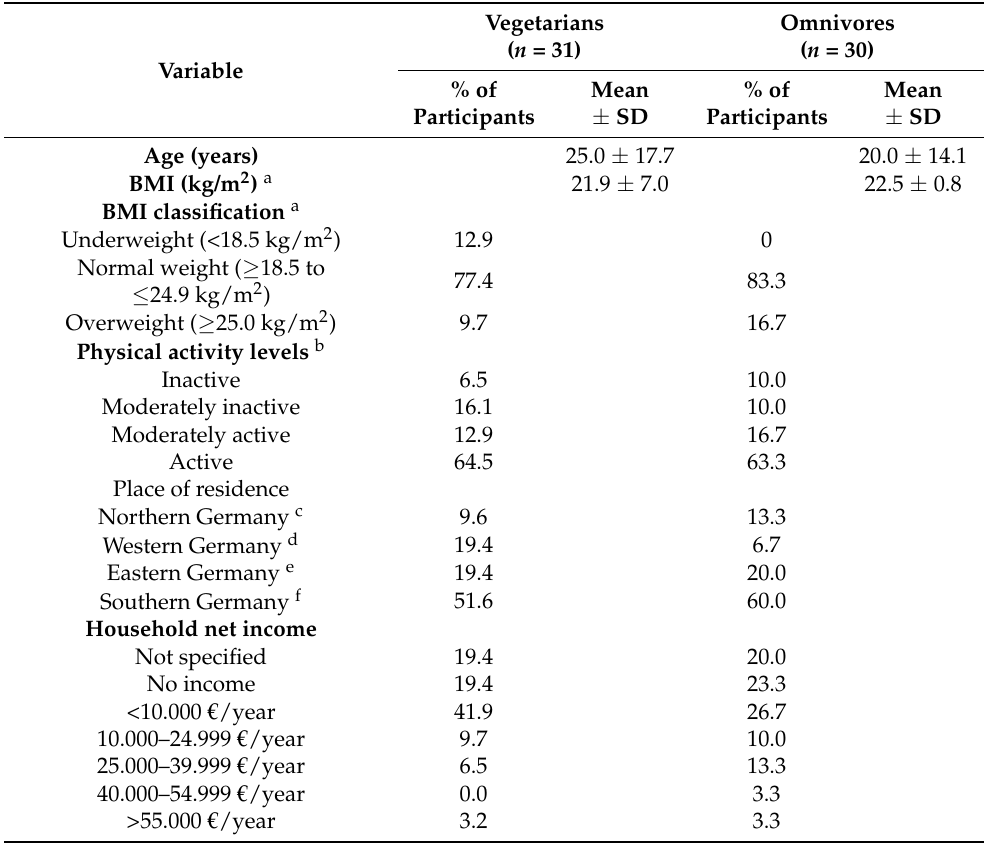
Table 1. Study population